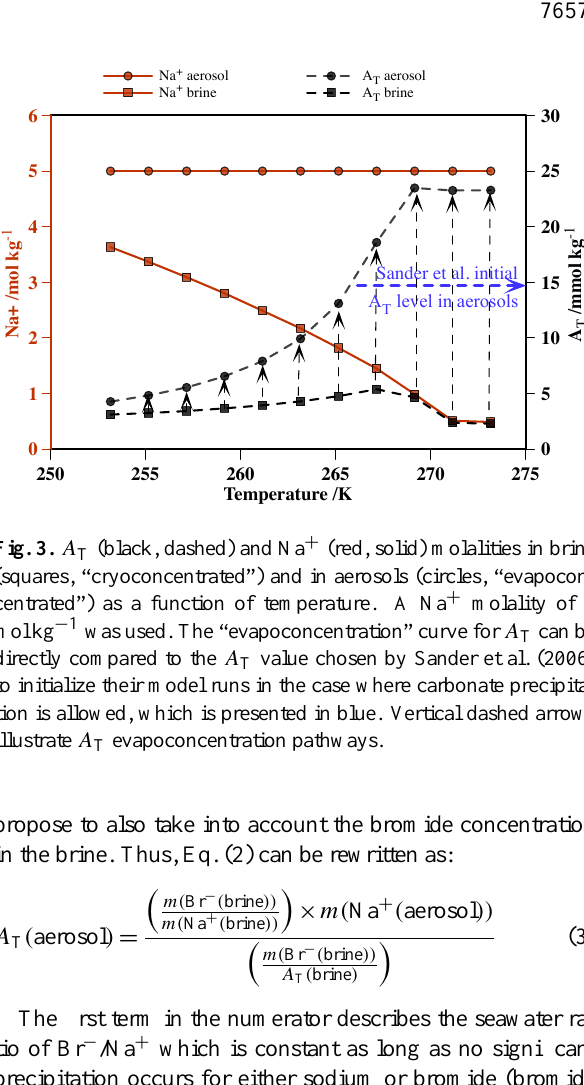
Fig. 4. The ratio of bromide to alkalinity during the freezing of sea water.